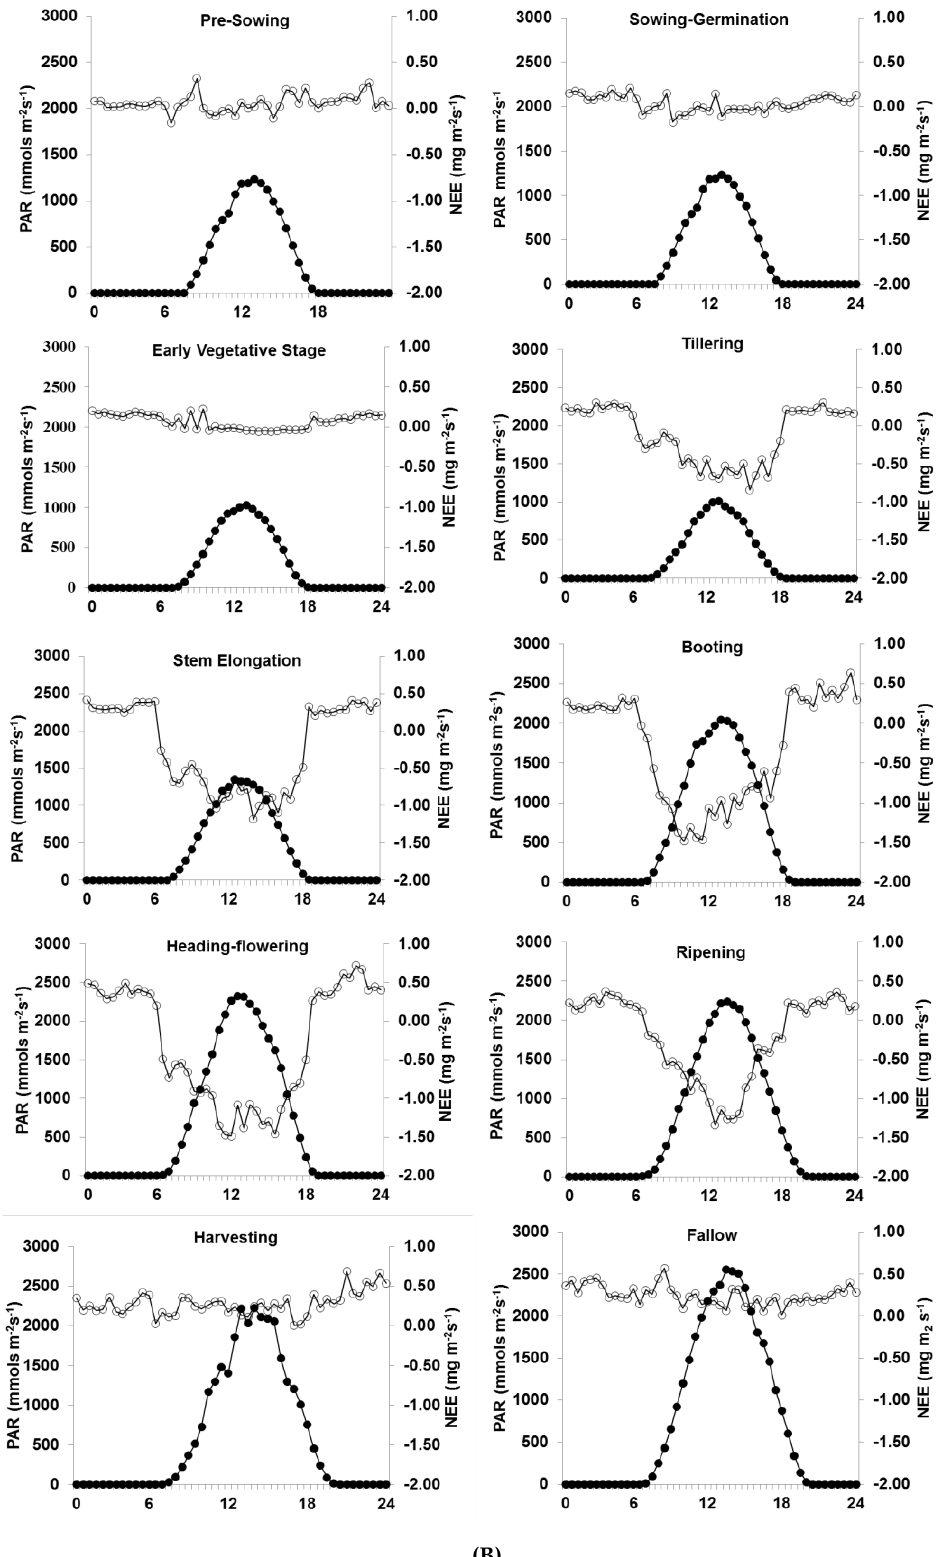
Figure 3. ( A ). Diurnal variation in NEE (empty circle) and incident photosynthetically active radiation (PAR) (filled circle) at half hourly interval, averaged for different rice growth stages. ( B ). Diurnal variation in NEE of CO 2 (empty circle) and incident PAR (filled circle) at half hourly interval, averaged for different wheat growth stages.